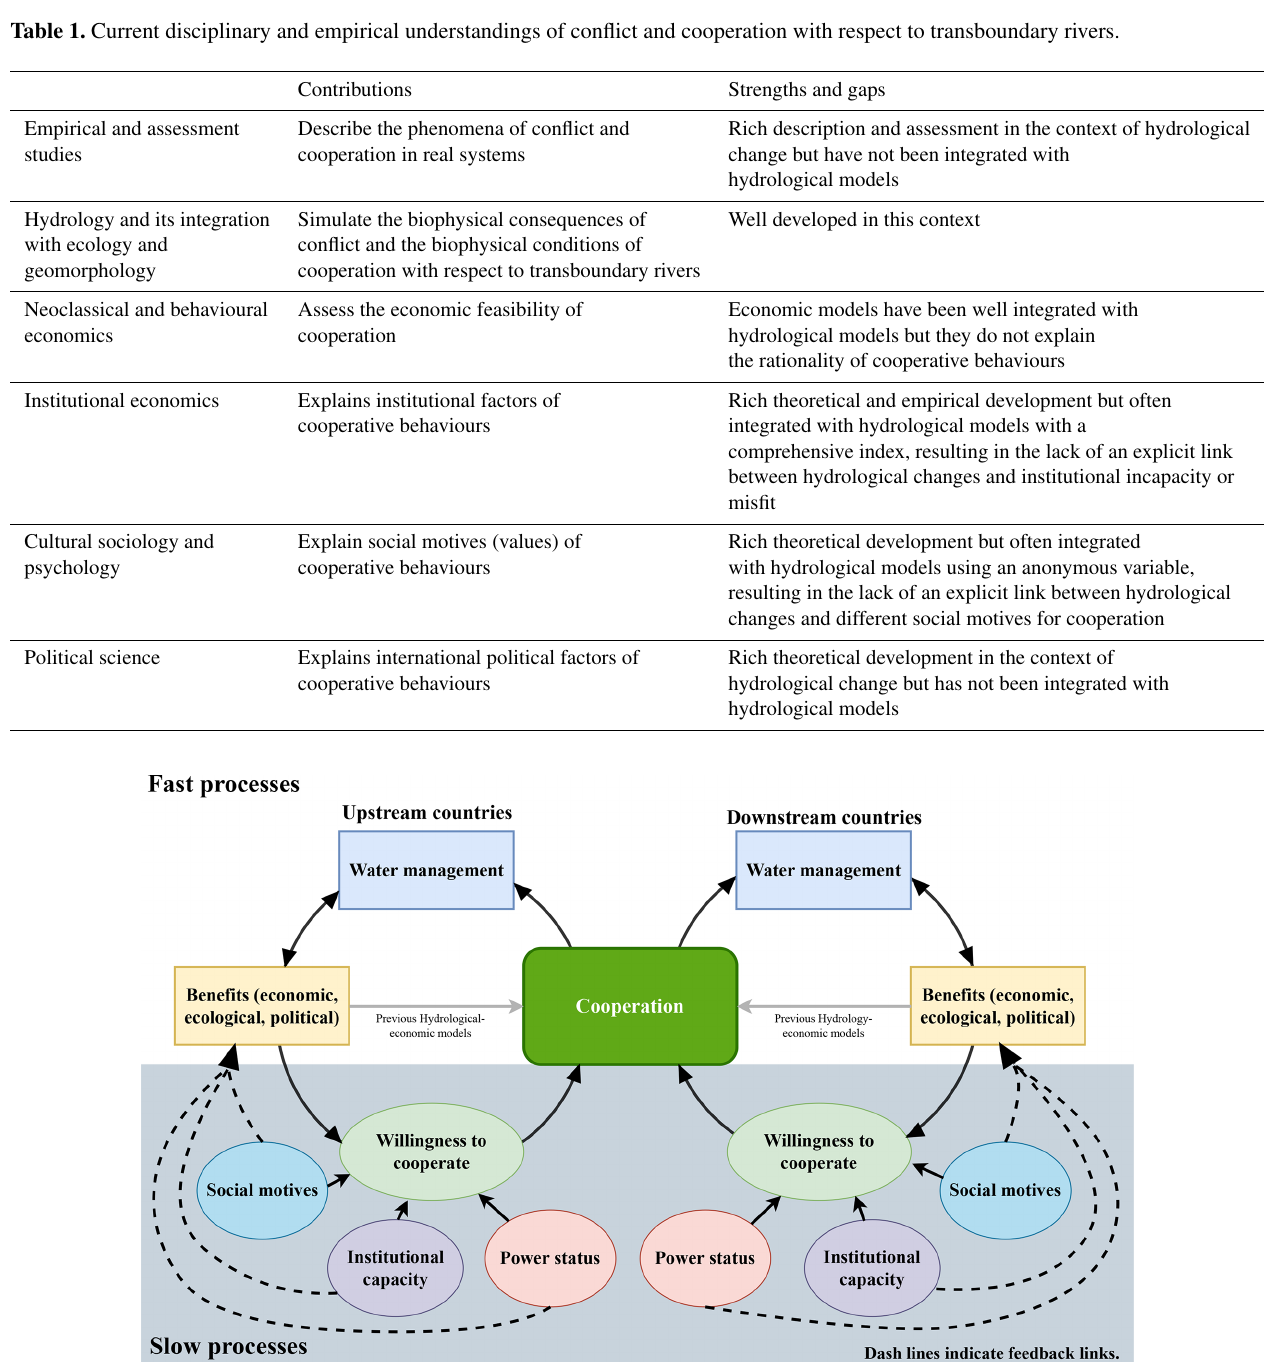
ditions, change in the resultant benefits, and cooperation as a result of their interactive feedbacks (as indicated in the upper part of Fig.